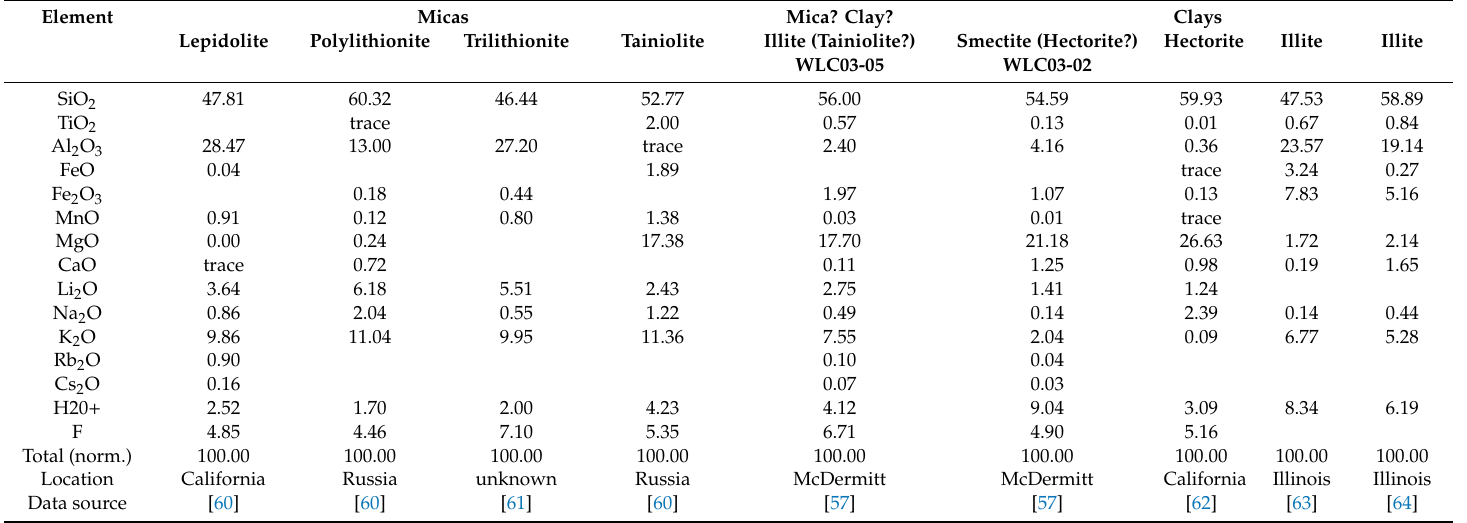
Table 4. Chemical composition of lithium micas, McDermitt lithium-rich clay and